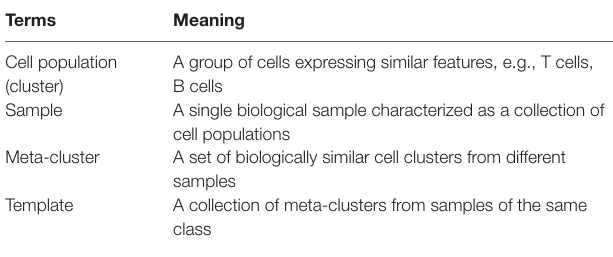
TaBle 1 | summary of terminology used in this